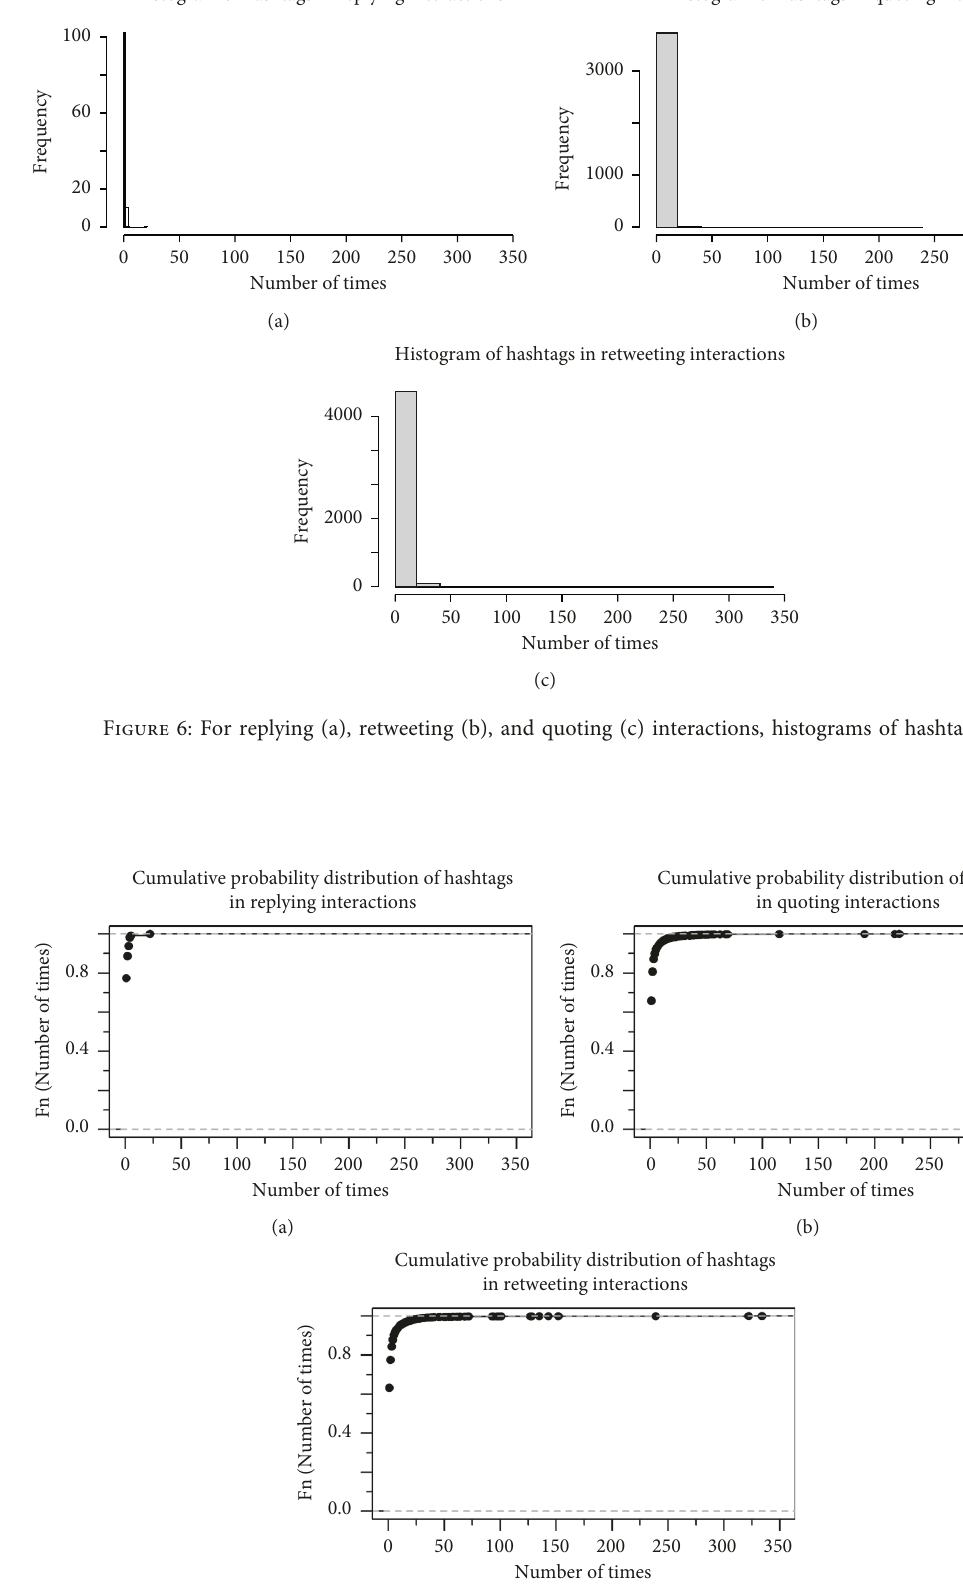
Figure 7: For replying (a), retweeting (b), and quoting (c) interactions, cumulative distribution of